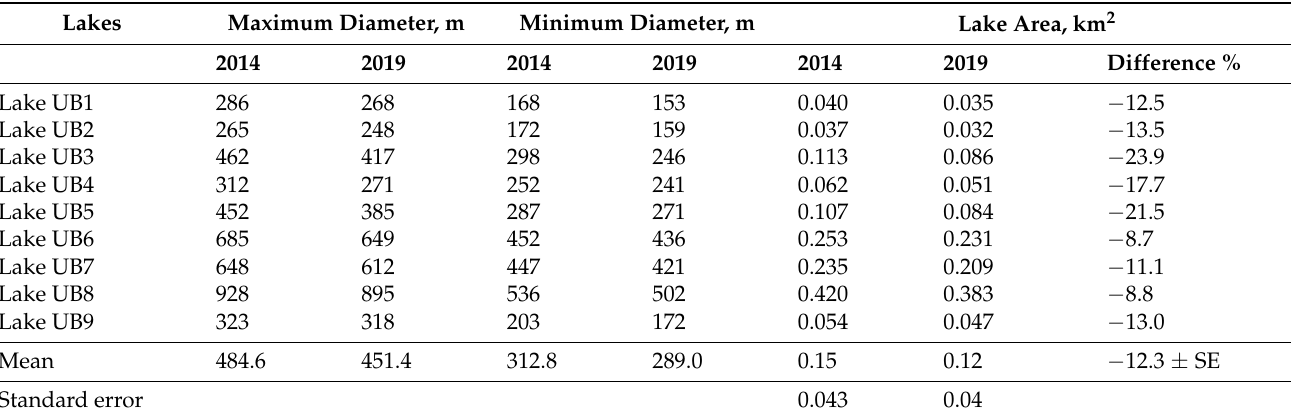
Table 2. Dynamics of the undisturbed lakes below the